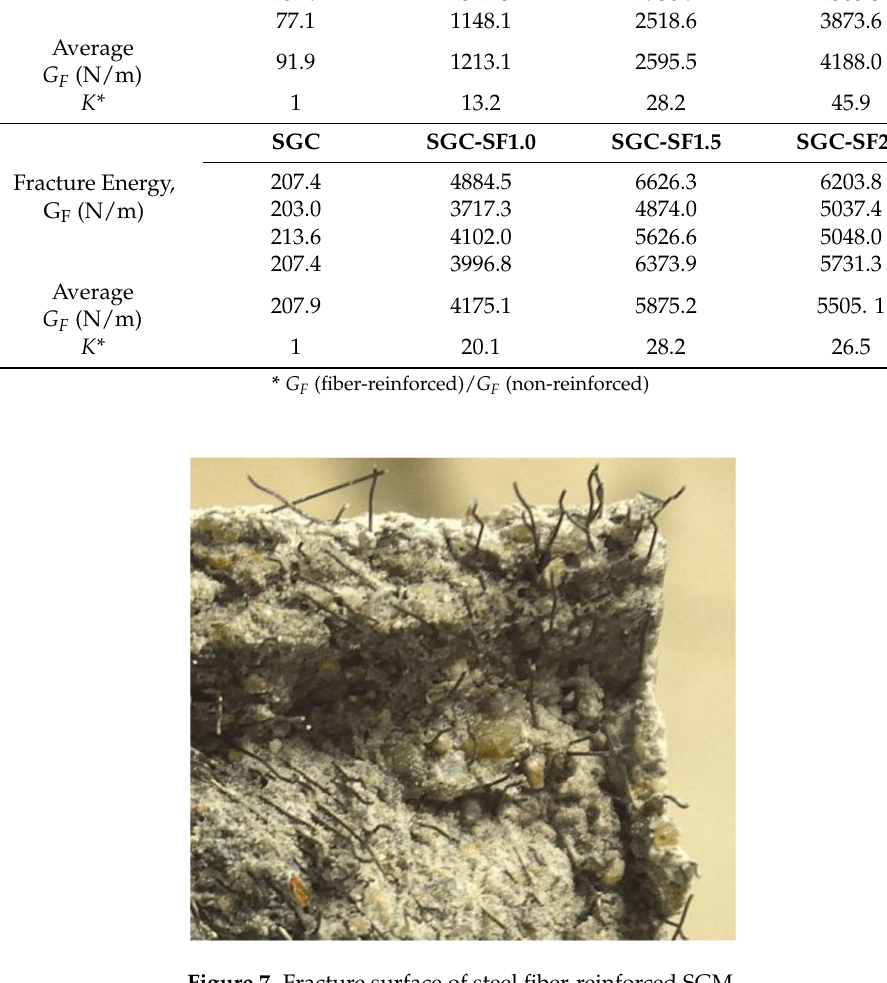
Figure 7. Fracture surface of steel fiber-reinforced